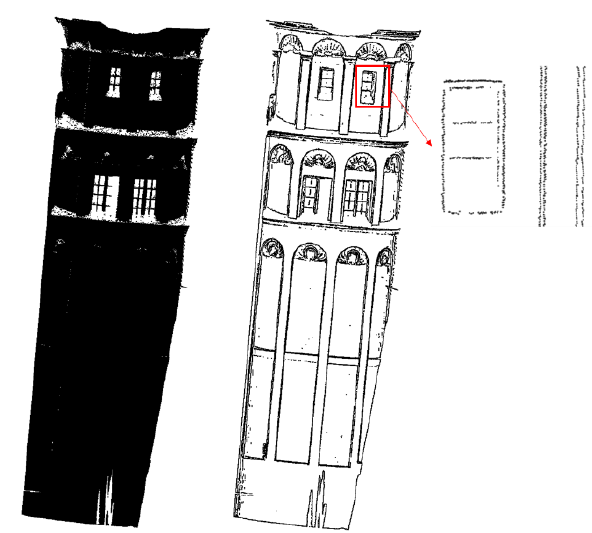
Figure 1. The 3D-edge detection result of a curve building facade, the left picture is the input point cloud, the middle picture is the 3D-edges detected by the employed AGPN method, and right picture is a small area of the middle